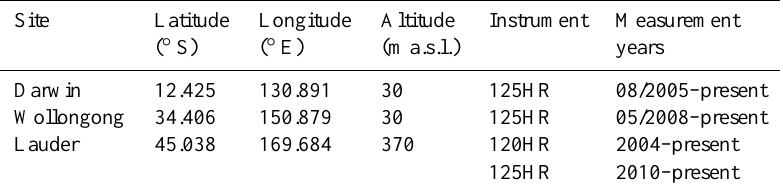
Table 2. Sites used in this study.